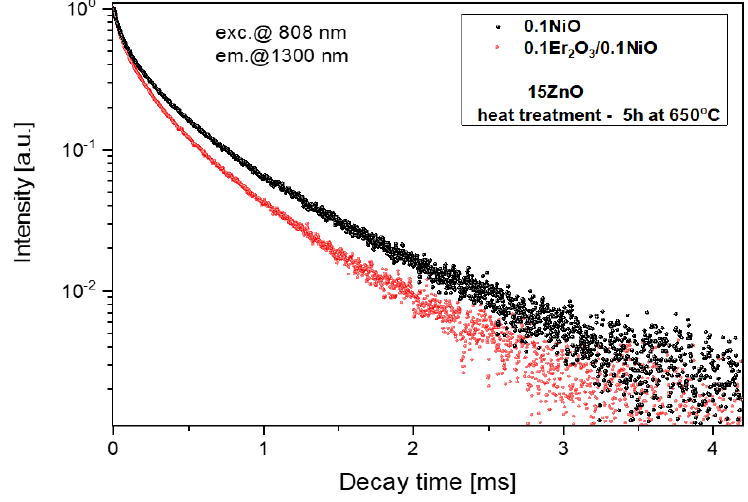
Figure 12. Luminescence decay curves from Ni 2+ : 3 T 2 ( 3 F) level, λ exc = 808 nm. According to Equation (4), the average lifetime of Ni 2+ : 3 T 2 ( 3 F) in the fabricated GGK with 15ZnO glass-ceramics (HT@650 °C for 5 h) was calculated to be 433 μ s (0.1NiO), and 349 μ s (0.1NiO/0.1Er 2 O 3 ). Thus, the efficiency of Ni 2+ → Er 3+ energy transfer (ET) was de- termined to be 19%. In the literature, in CaZrO 3 nanocrystals co-doped with 0.2Ni/10Er (mol.%), the efficiency of the nickel to erbium energy transfer was estimated to be 86% [42]. In contrast, in silicate glass-ceramics with ZnGa 2 O 4 nanocrystals (HT@ 850–950 ° C) energy transfer between Ni 2+ and Er 3+ was suppressed [15]. It indicates that in the analyzed germanate glass-ceramics Ni 2+ to Er 3+ energy transfer occurs in the crystalline phase. Fig- ure 13 presents the effect of the HT time GGK with 15 ZnO glass on the lifetime of Ni 2+ : 3 T 2 ( 3 F) and Er 3+ : 4 I 13/2 metastable levels. Due to the incorporation of the nickel ions into ZnGa 2 O 4 nanocrystals, the lifetime of the Ni 2+ level increases with increasing the HT time and was calculated to be 62 μ s (as-melted glass) and 433 μ s (glass ceramics, HT–5 h). In silicate glass-ceramics with ZnGa 2 O 4 and CaZrO 3 nanocrystals, this value was 730 μ s [12] and 600 μ s [45], respectively. On the other hand, in silicate glass-ceramics with LiGa 5 O 8